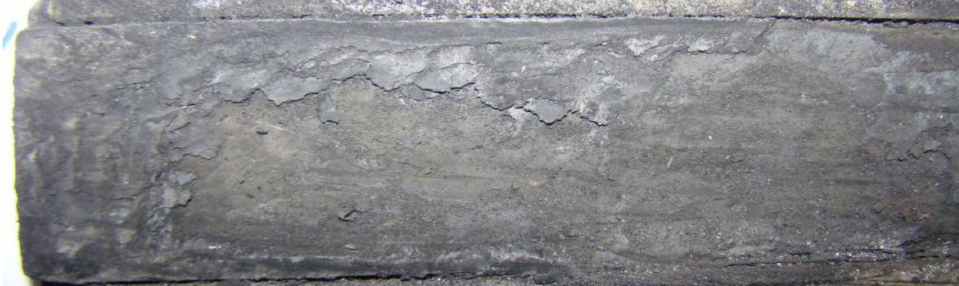
Figure 13. Surface state of insulation layer after first ablative experiment (gas phase velocity was 2 m/s).